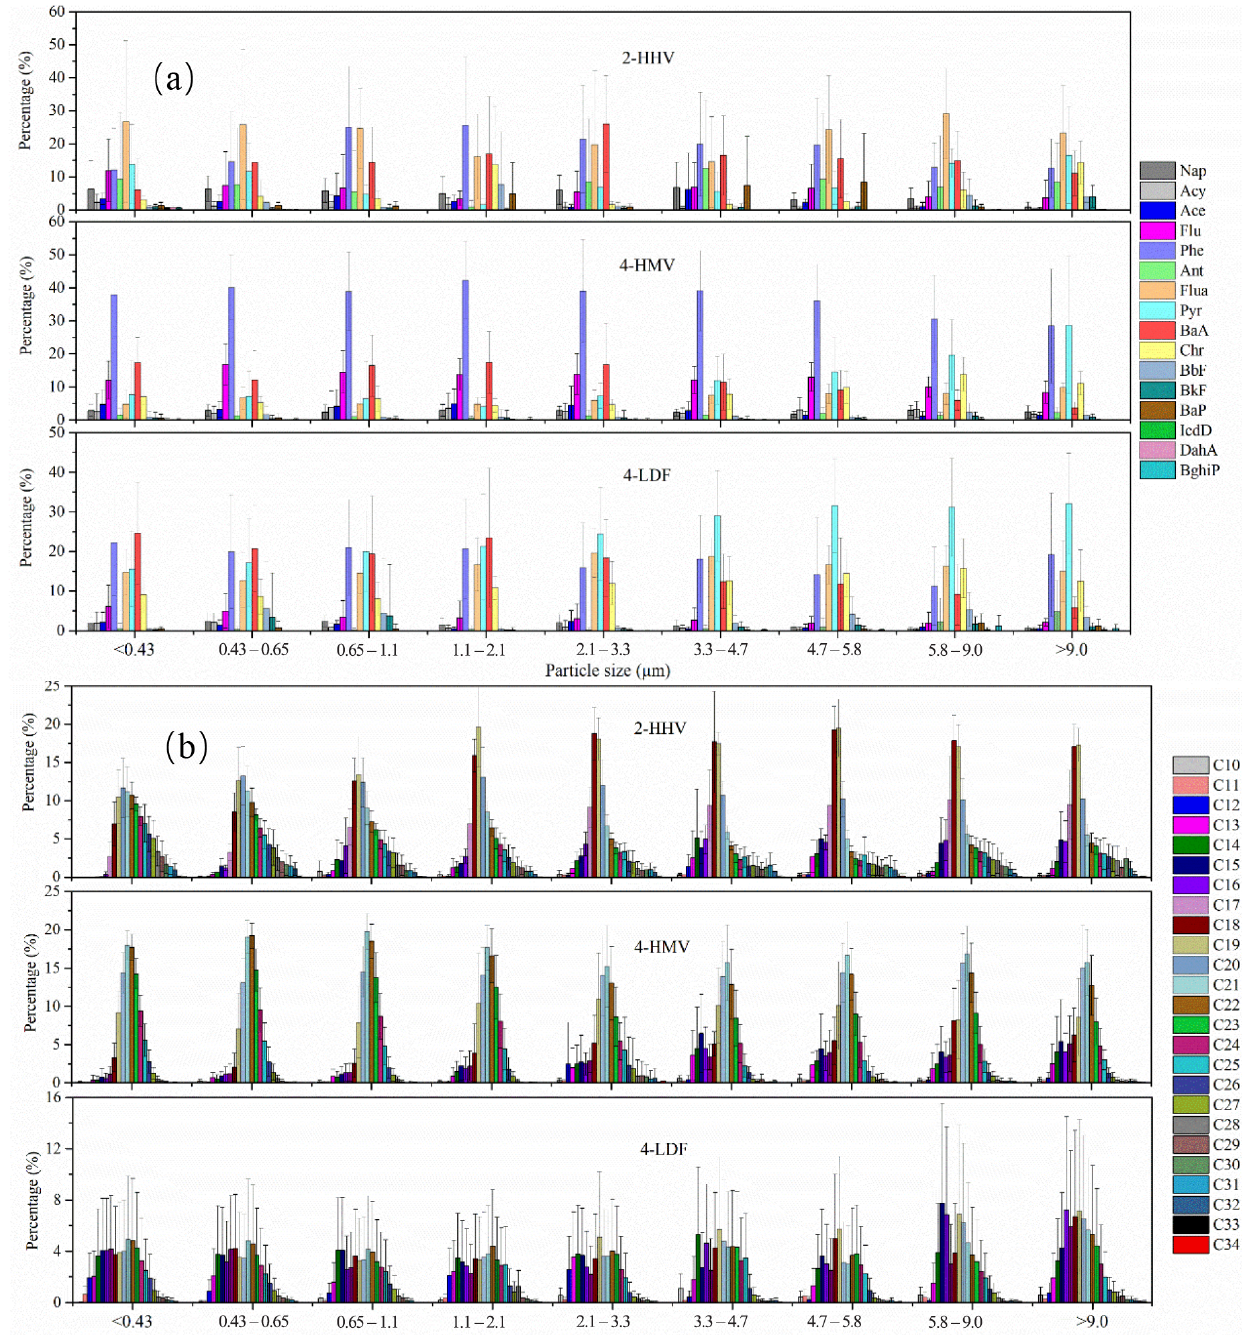
Figure 8. Speciated profiles of PAHs (a) and n -alkanes (b) in size-resolved